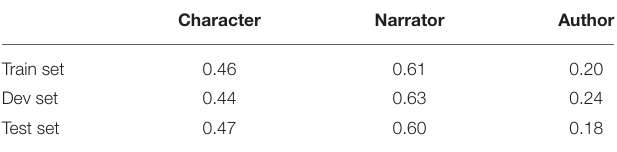
TABLE 3 | Label distributions in training, development and test